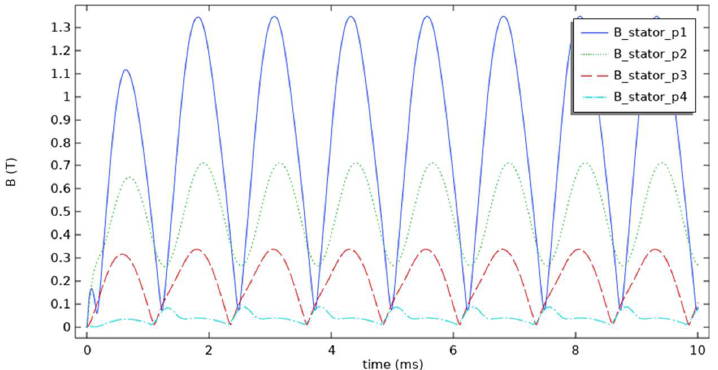
Figure 5. The flux density of stator. Sampling points were at the four corners of the stator coil.